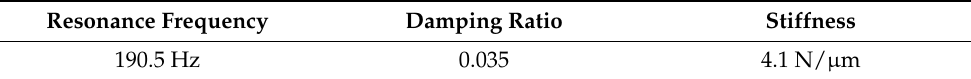
Table 2. Characteristic values of the resilient bearing suspension incorporating O-ring seals with a cord diameter of 2 mm.